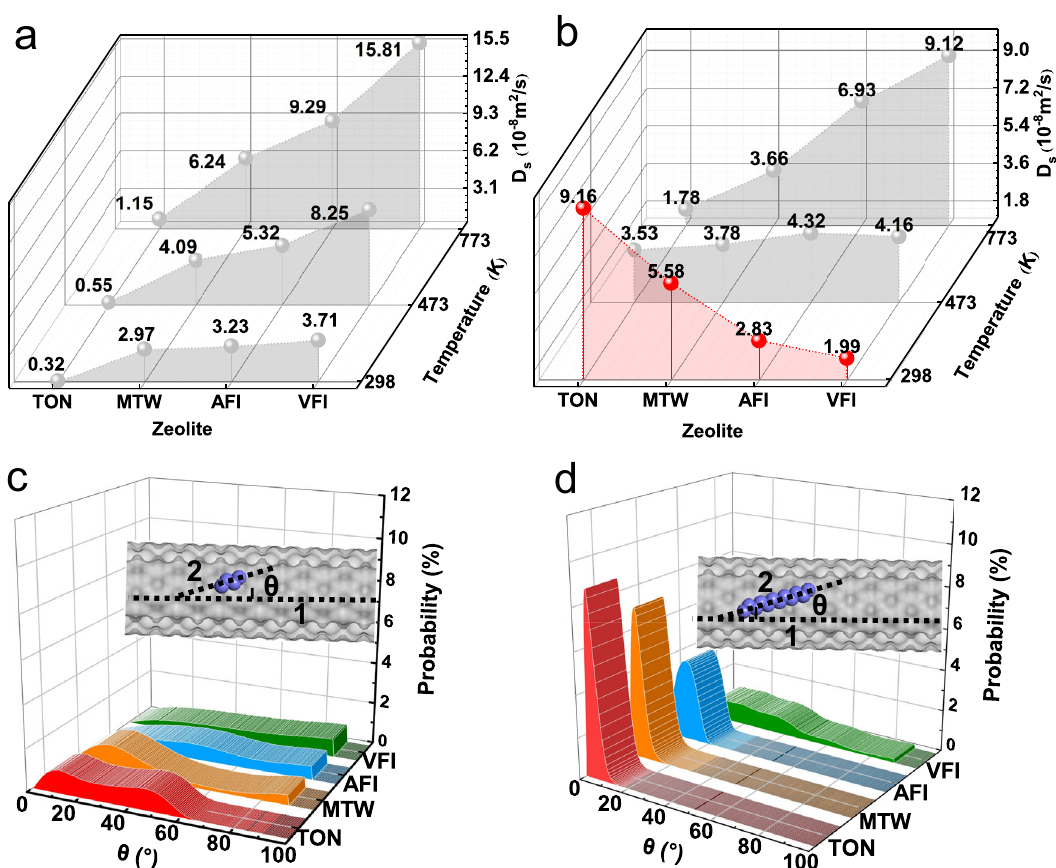
Fig. 2 | Self-diffusion coef fi cients and the deviation angles for the alkane molecules in the zeolites. The self-diffusion coef fi cients of a n-butane (C4) and b n-dodecane(C12)inthe1Dchannelzeoliteatvarioustemperatures(Thegrayballs represent the data points). The deviation angle between the axial direction of the